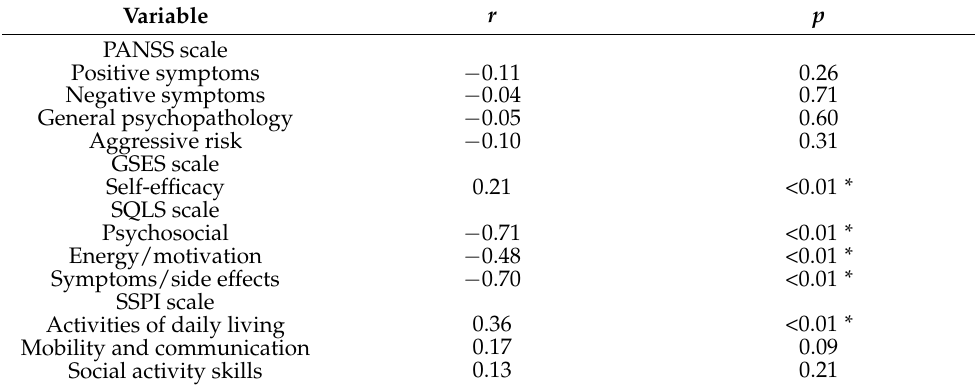
Table 2. Correlation analysis of medication adherence of patients with